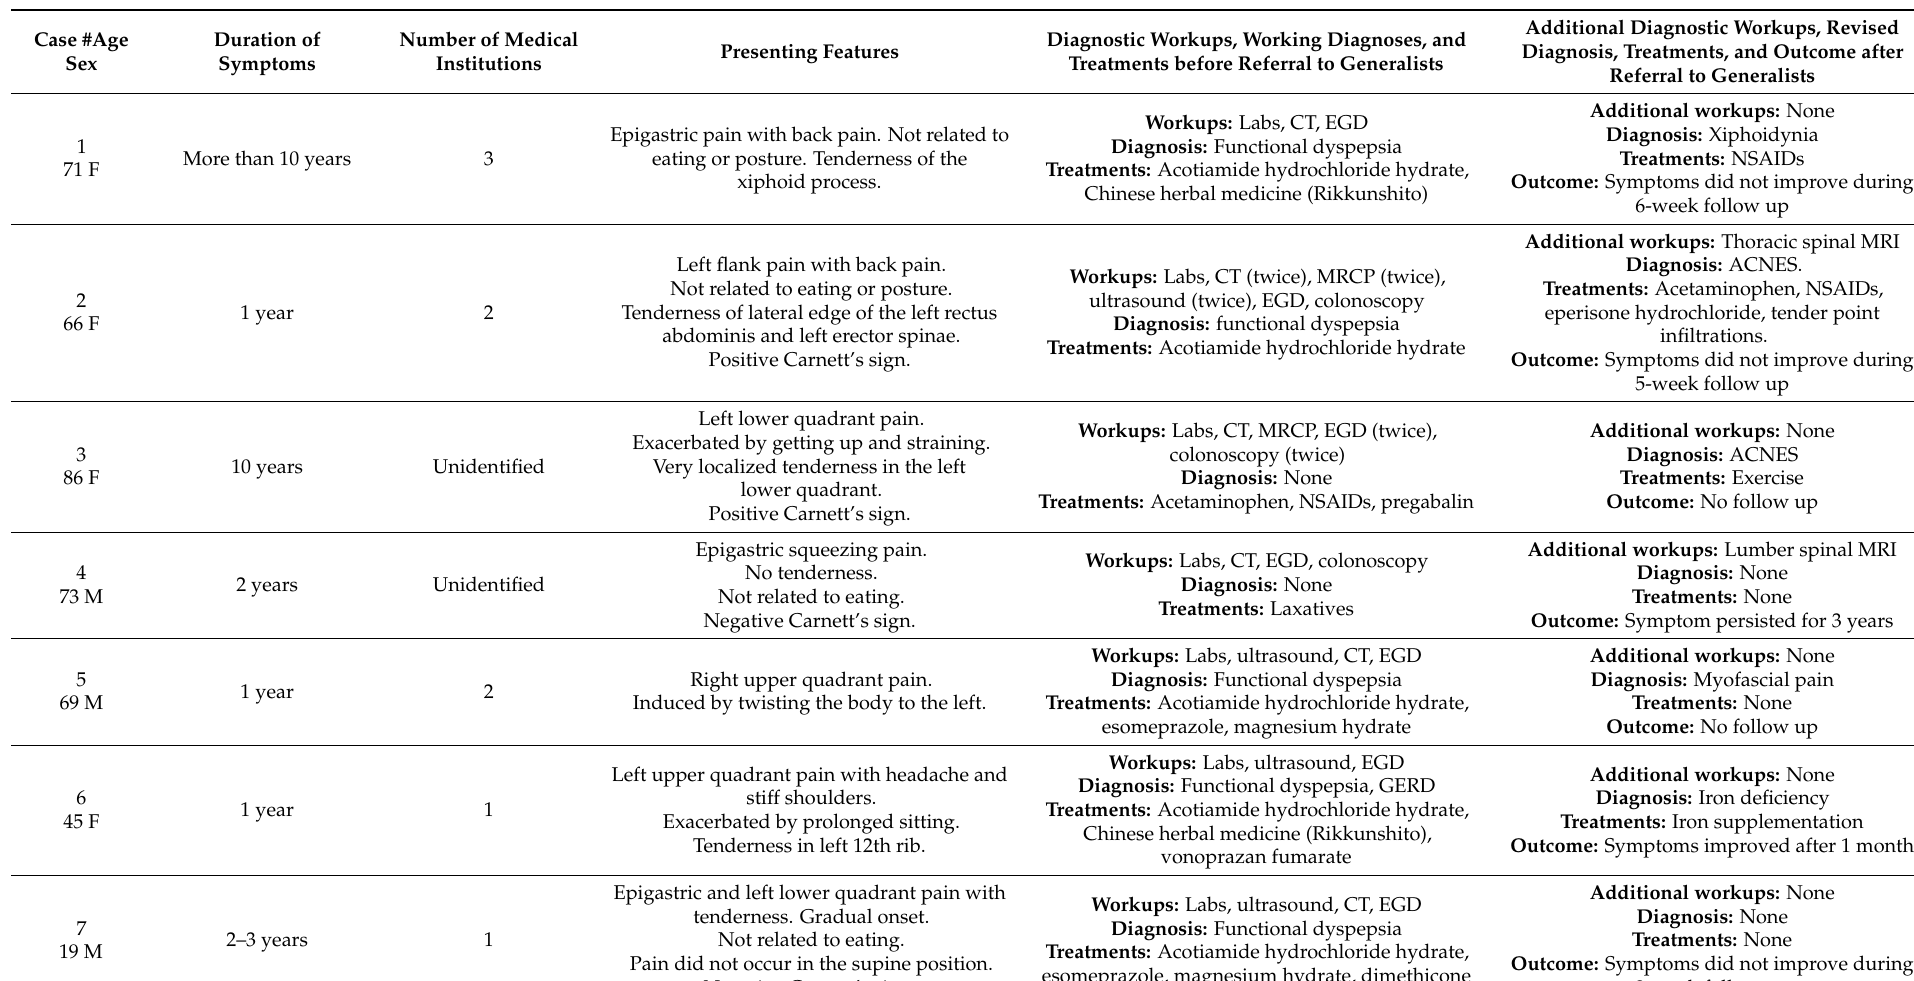
Table 1. Twelve patients with undiagnosed abdominal